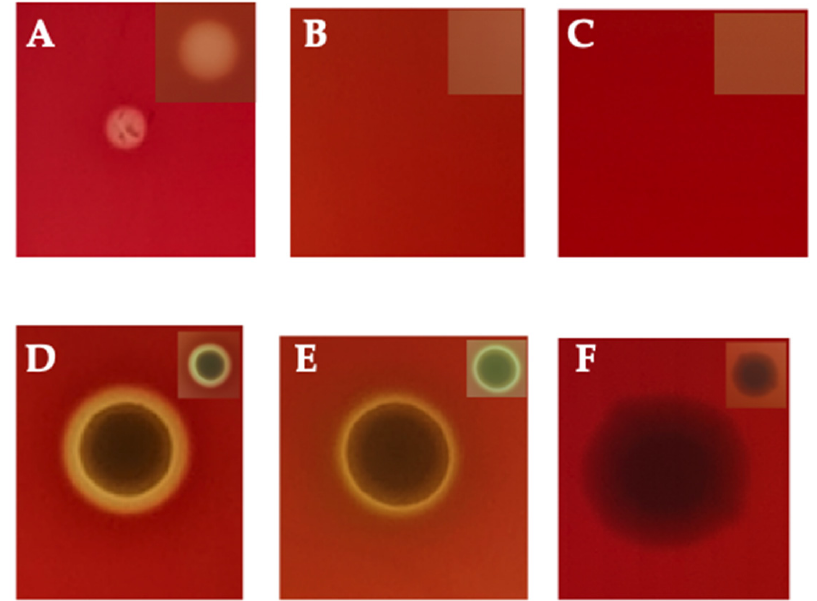
Figure 6. Hemolytic profile in blood agar hemolysis assay in the presence and absence of CaCl 2 : ( A ). rHlyA in the presence of CaCl 2 ; ( B ). rHlyA in the absence of CaCl 2 ; ( C ). PBS 0.01 M pH 7.2; ( D ). Hemolysin-producing UPEC (DV73) strain in the presence of CaCl 2 ; ( E ). Hemolysin-producing UPEC (DV73) strain in the absence of CaCl 2 ; ( F ). Non-hemolysin-producing UPEC strain (DH5 α ). The figures represent the amplified pictures inserted in the top right corner.